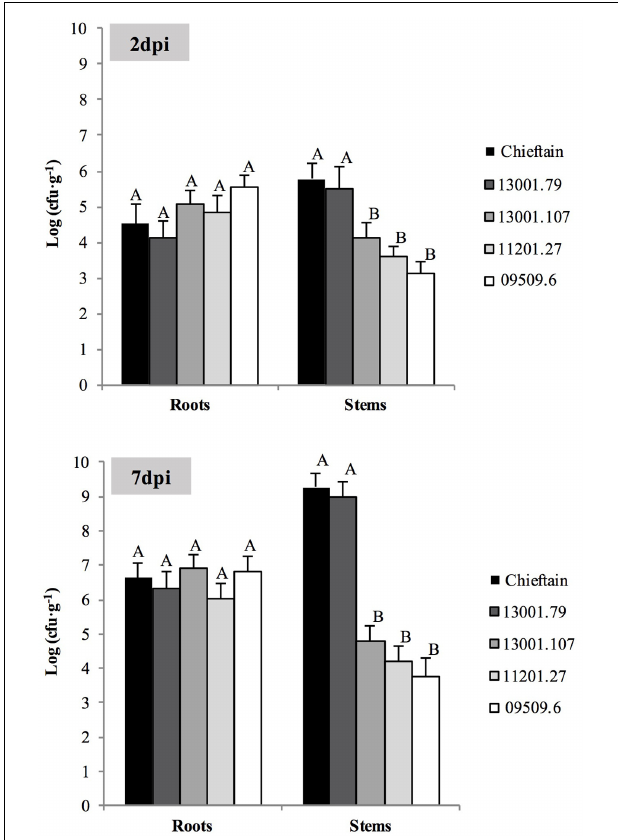
FIGURE 5 | Bacterial populations in roots and stems of susceptible and tolerant potato genotypes 2 (A) and 7 (B) days post inoculation (dpi) with R. solanacearum strain UY031 Pps-GFP. Each column represents the mean bacterial load ( n = 6) determined by plate counting in roots and stems samples of the susceptible potato cultivar S. tuberosum cv. Chieftain and interspecific potato breeding lines with different levels of bacterial wilt resistance including susceptible (13001.79) and tolerant (13001.107, 11201.27, and 09509.6) clones. Columns with the same letter within each sample type (roots, stems) are not significantly different according the Tukey’s multiple comparison test ( P = 0.05). Vertical bars represent standard errors of the